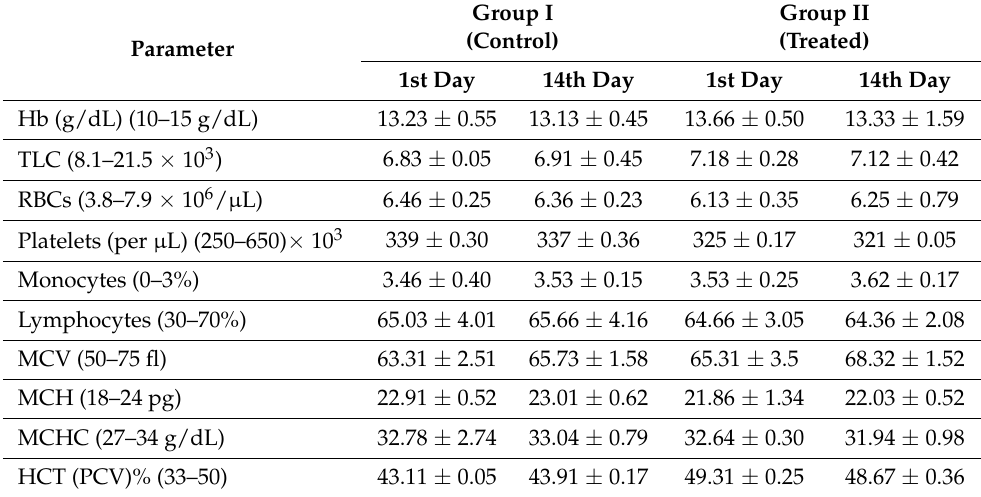
Table 4. Results of hematological and biochemical analysis.